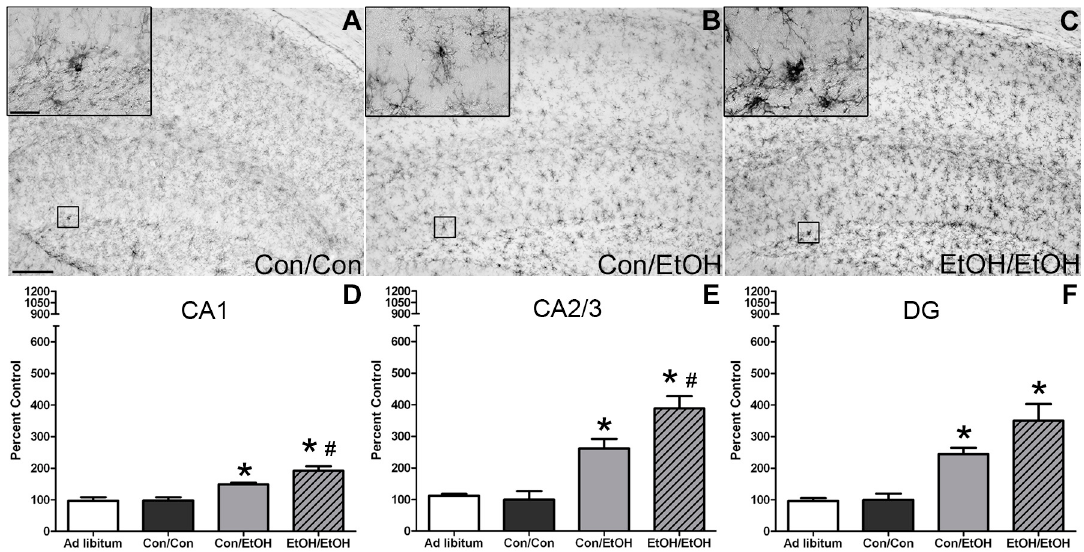
Figure 1. Potentiated Microglial Activation in the Hippocampus by Repeated Ethanol Exposure. OX-42 (CD11b/c) is upregulated in the hippocampus of ethanol-exposed rats as shown in representative photomicrographs of the ( A – C ) hippocampal dentate gyrus for ( B ) Con/EtOH and ( C ) EtOH/EtOH groups compared to ( A ) controls. Analysis of OX-42 immunoreactivity indicated that the EtOH/EtOH group had significantly more staining than the Con/EtOH group in the: ( D ) cornu amonis 1 (CA1) and ( E ) cornu amonis 2/3 (CA2/3) regions but not the (F) dentate gyrus (DG). Data expressed as a percentage of ad libitum control (not shown). Images were taken at 50× magnification with insets at 600× magnification. Scale bar = 200 µm; inset 30 µm. * p < 0.05 compared to ad libitum and Con/Con groups; # p < 0.05 compared to Con/EtOH.